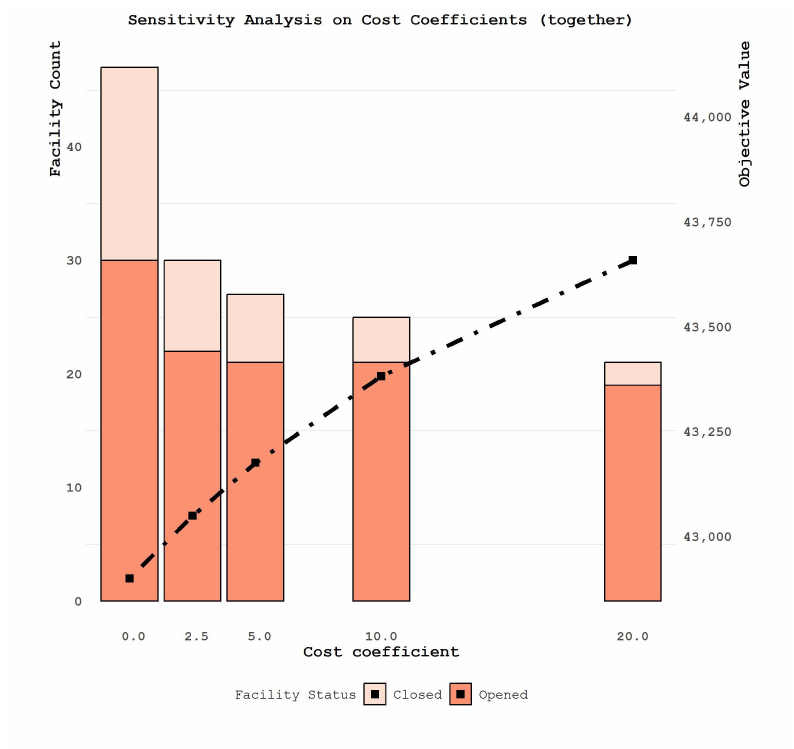
Figure 6. The impact of opening/closing cost of facilities on the objective functions, the dotted line represents the objective